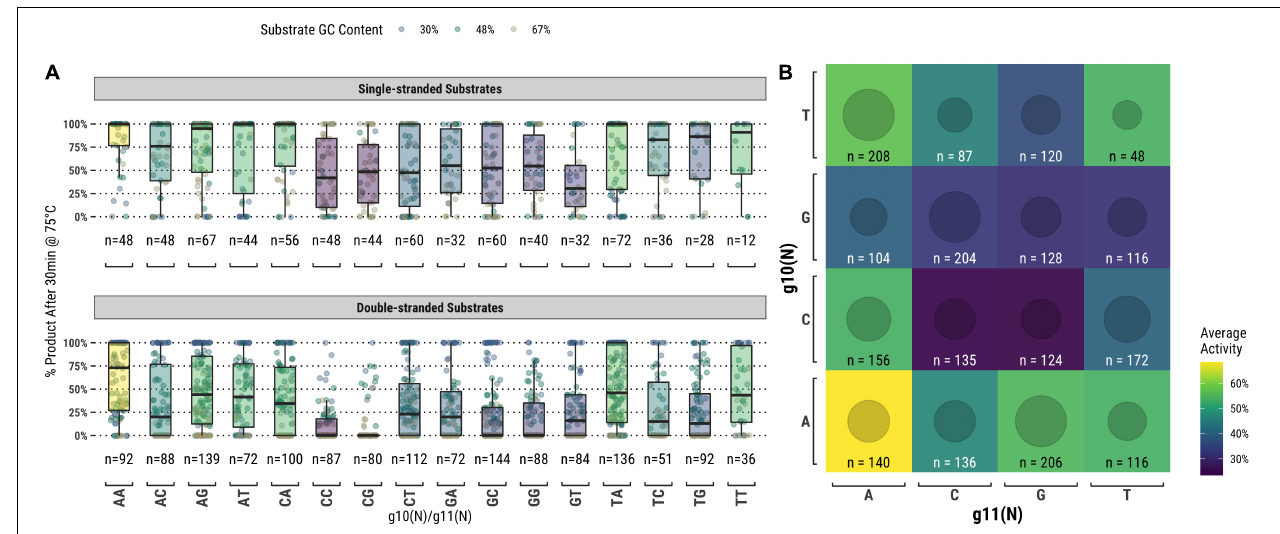
FIGURE 5 | TtAgo shows a preference for low GC content dinucleotides at the g10/g11 positions which align with the enzyme active site. (A) Populations expressed as box plots individually for single- and double-stranded substrates. (B) Single- and double-stranded substrates combined and expressed as a heatmap.